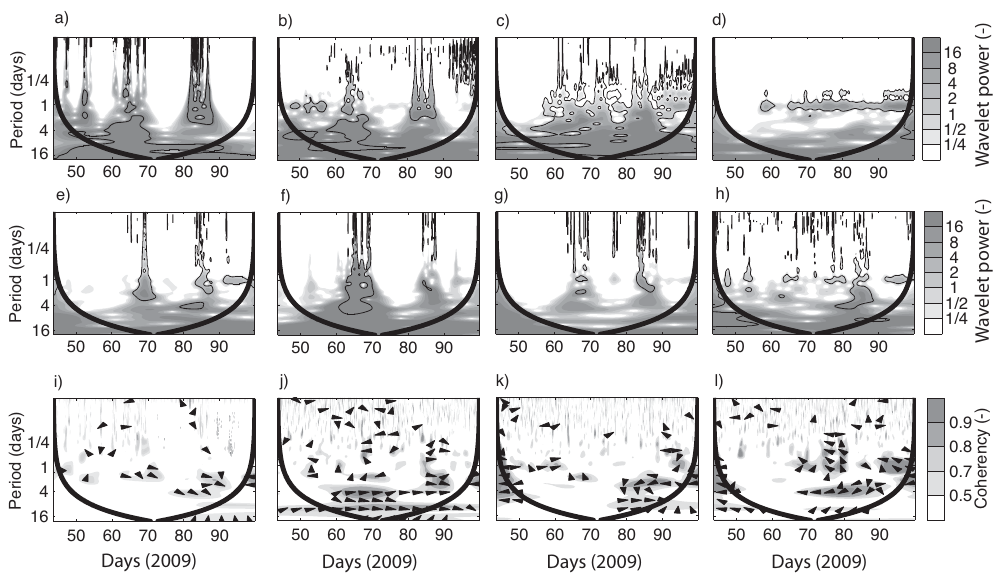
Fig. 5. The wavelet power spectra (WPS) for (a) rainfall intensity, (b) water content at 10cm depth at station SB2M, (c) hydraulic head for piezometer R042, (d) soil temperature at 10 cm depth at station SB2M, (e) SP5, (f) SP3, (g) SP11, (h) SP2. The 5% significance level against red noise is shown as contour lines in a–h. Regions outside the thick solid lines (cone of influence) are increasingly affected by edge effects. Wavelet coherency between (i) rainfall intensity and SP5, (j) water content and SP3, (k) hydraulic head and SP11, (l) soil temperature and SP2. The arrows indicate the phase relation between the two time-series when the wavelet coherency is above 0.5 (in-phase when pointing right; anti-phase when pointing left; series 1 leading series 2 by 90 ◦ when pointing